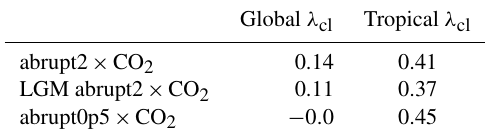
Table 5. Global and tropical (30 ◦ S–30 ◦ N) cloud feedback λ cl val- ues computed with the PRP method for three simulations performed with MPI-ESM1.2-LR. Global λ cl Tropical λ cl abrupt2 × CO 2 0.14 0.41 LGM abrupt2 × CO 2 0.11 0.37 abrupt0p5 × CO 2 − 0 . 0